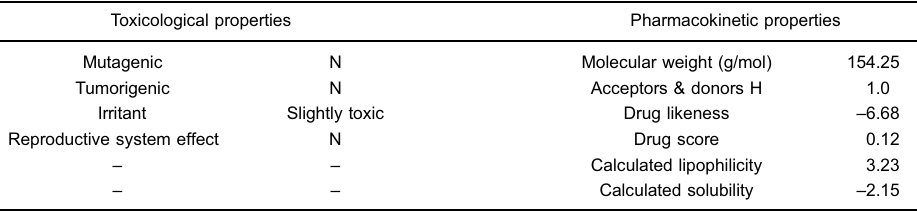
Table 6. Toxicological properties of linalool assessed through Osiris property explorer. Toxicological